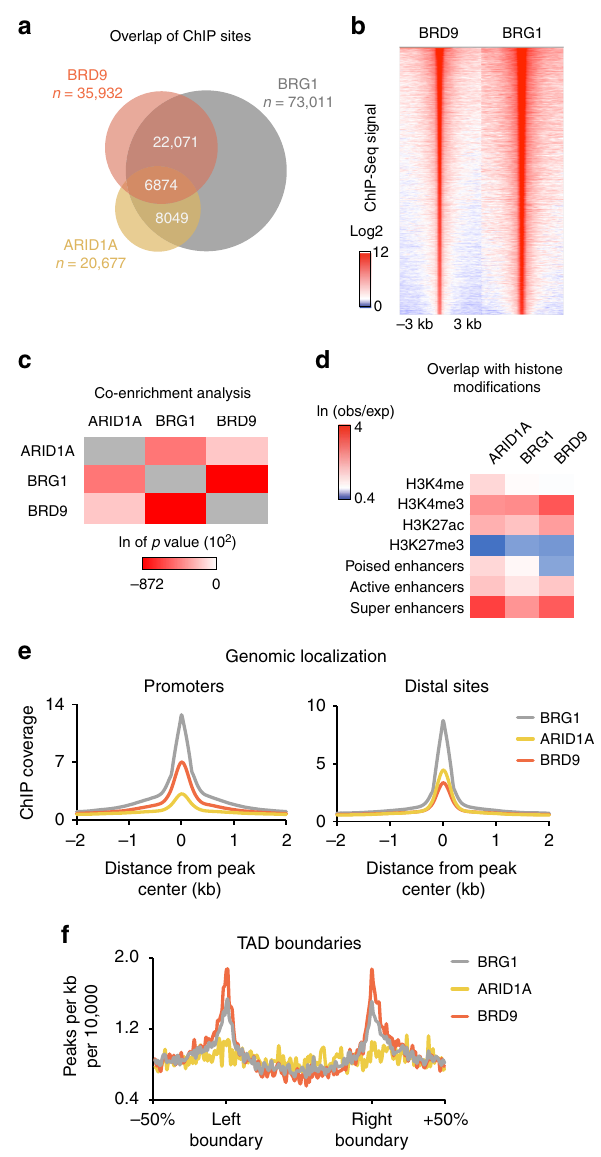
Fig. 3 GBAF and esBAF localize to distinct genomic elements. a Venn diagram overlap of BRG1, BRD9, and ARID1A ChIP sites, with n representing the number of observed peaks. b Heat map of BRD9 and BRG1 ChIP signal ± 3 kilobases (kb) centered on the BRD9 peak, ranked according to BRD9 read density. c Signi fi cance of binding overlap between BRD9, BRG1, and ARID1A ChIP sites. The natural log of p values were calculated using hypergeometric distribution (mergePeaks.pl in HOMER). d Co-occurrence analysis showing the natural log of the ratio of the observed number of overlapping peaks over the expected values. This was done for BRD9, BRG1, and ARID1A ChIP sites against publicly available ChIP-Seq data for